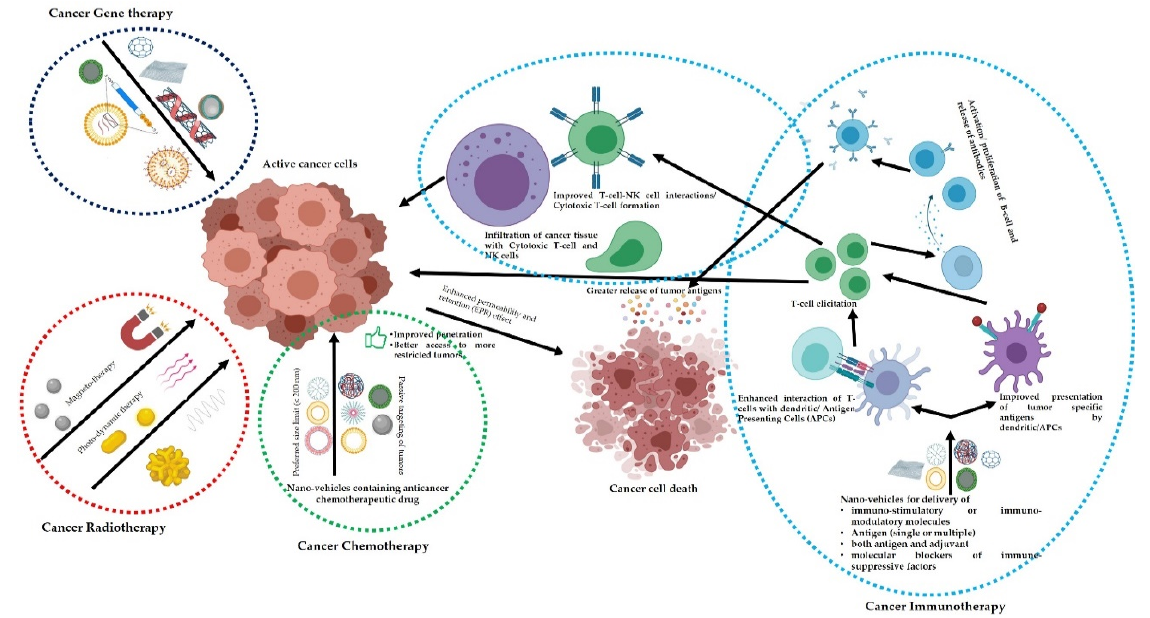
Figure 4. Immuno-modulatory and other functions of nano-antifungals for cancer therapeutics.